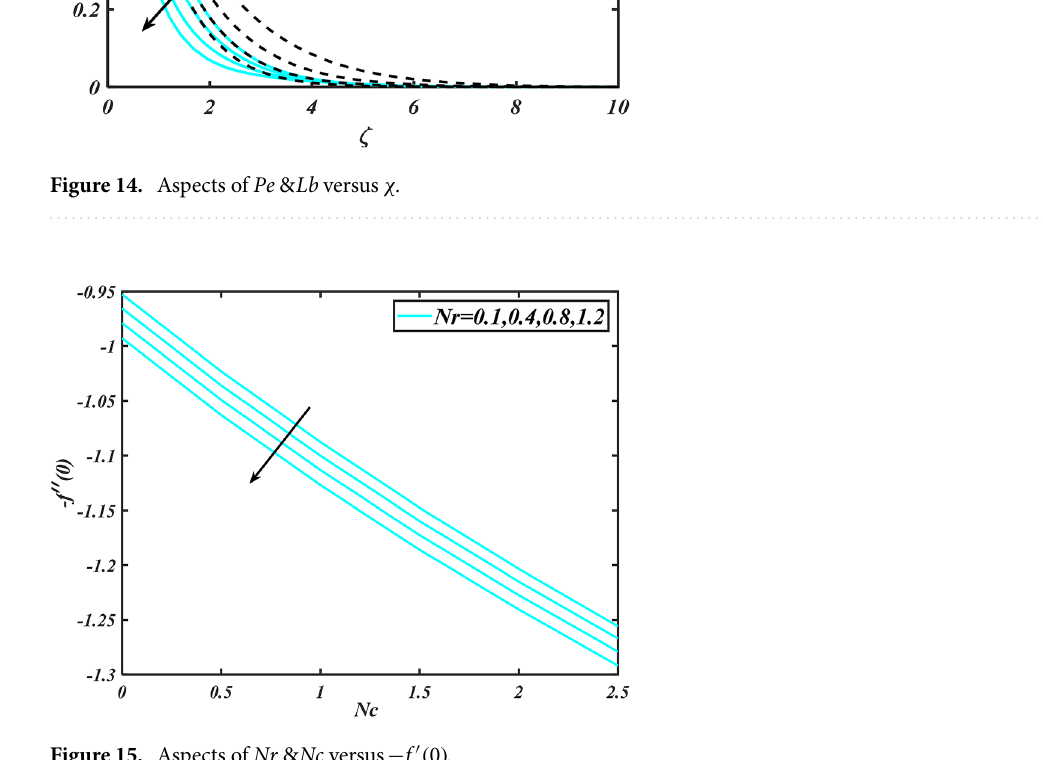
Figure 15. Aspects of Nr & Nc versus − f ′ ( 0 )